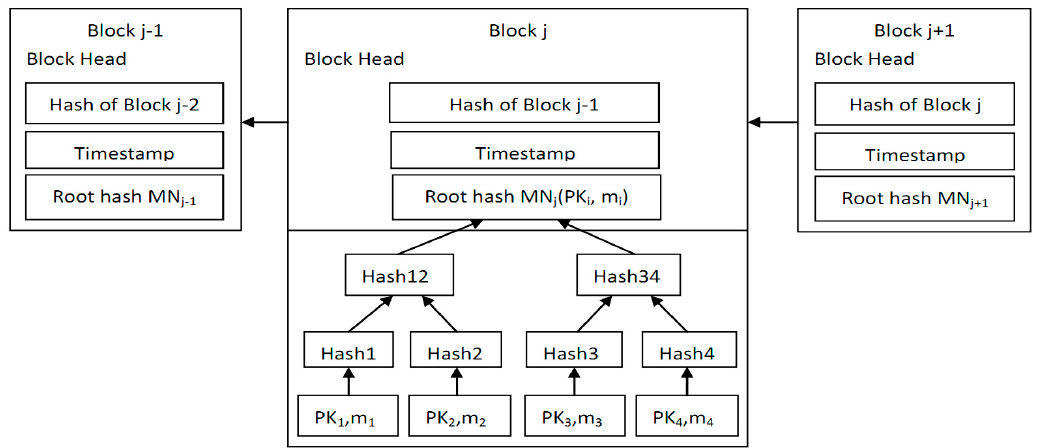
Figure 3. Blockchain structure in our scheme.